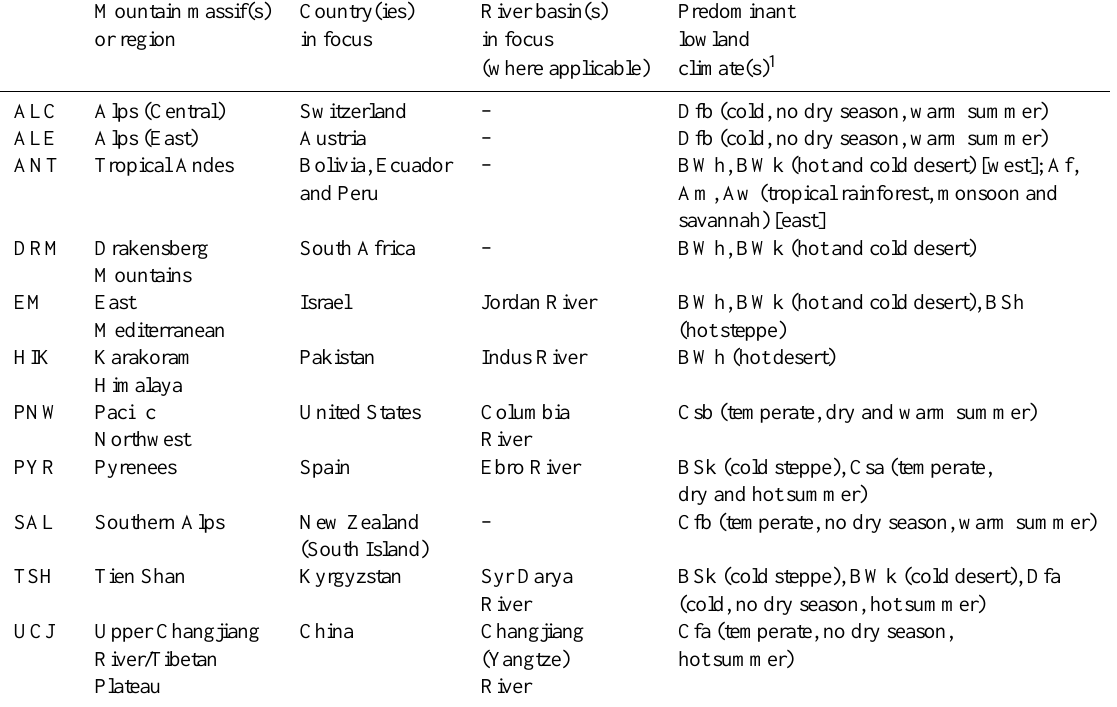
Table 1. Regions studied as a basis for the present